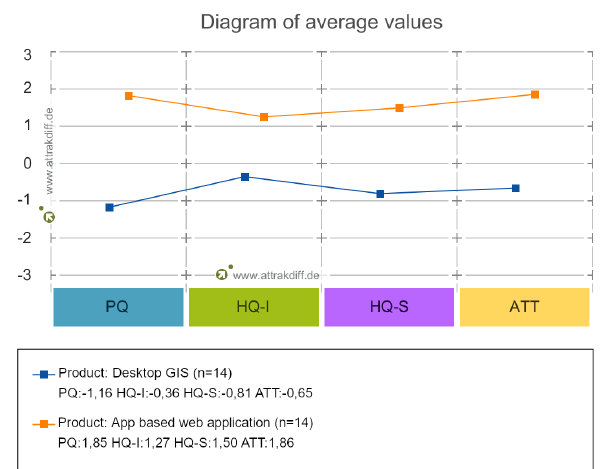
Figure 6. Result of UX-Measurement (Diagram of average values).